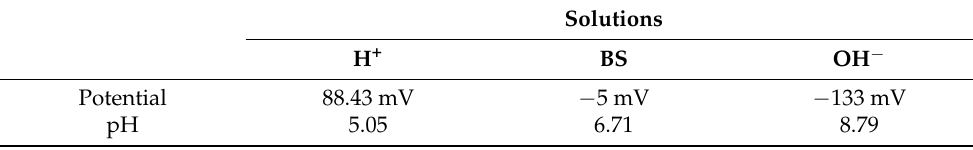
Table 3. Values obtained by reading the solution and acidified and basified solutions using electrode